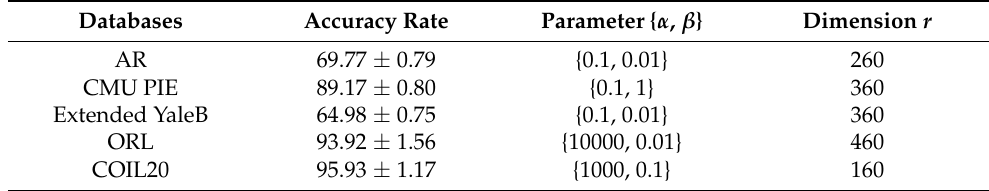
Table 6. The optimal combination of parameters and dimension on the classification task.